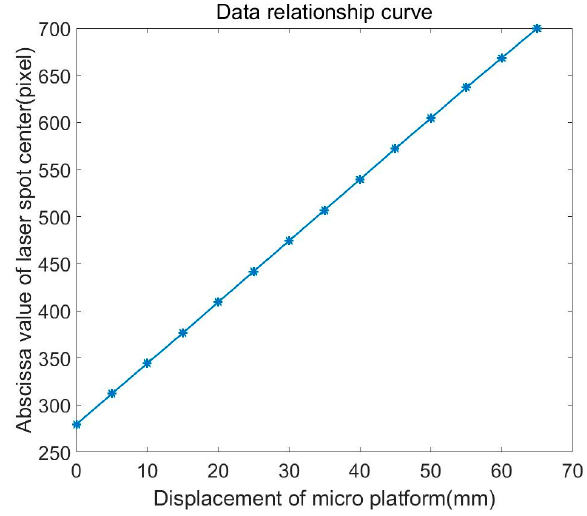
Figure 10. Data relation curve.